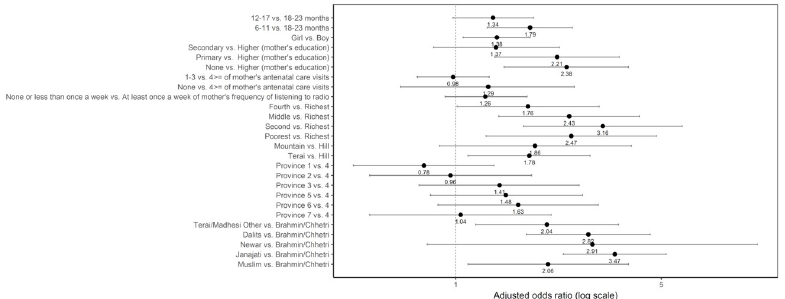
Fig 11. Odds ratio plot with 95% confidence intervals for not consuming dairy products among Nepalese children aged 6 to 23 months.